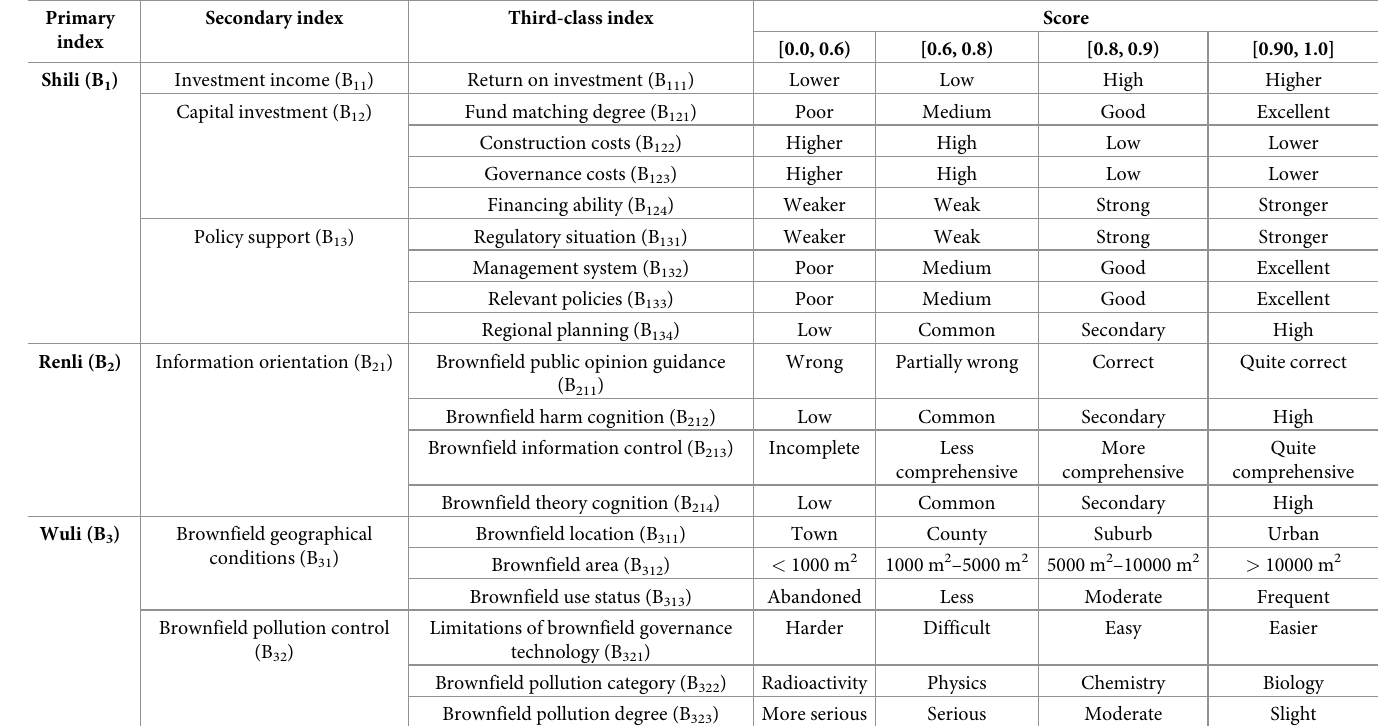
Table 13. Evaluation index system and scoring standard of brownfield redevelopment.